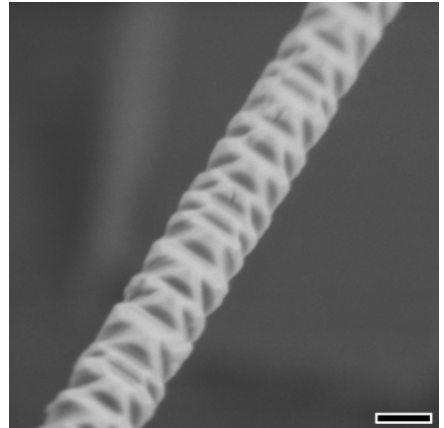
Figure 4 . InP nanowire with edged surfaces grown at 540 °C on a glass substrate (scale bar = 200